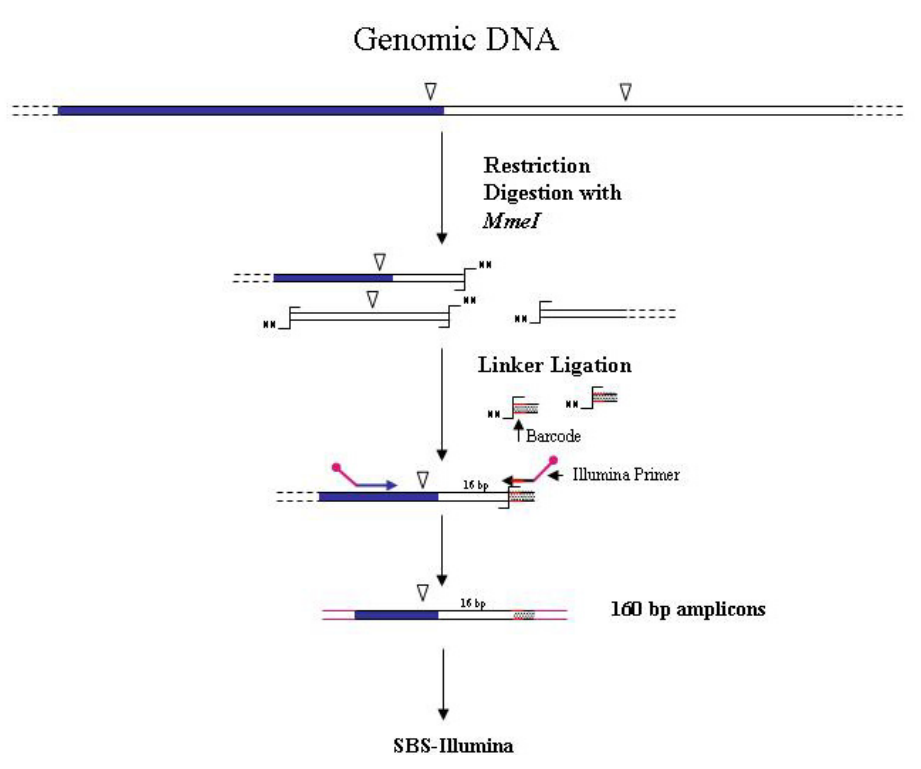
Figure 4. Main steps of MmeI -assisted cassette-PCR GW and SBS-Illumina association strategy. Blue and white bars correspond to known and unknown sequences, respectively. An open vertical arrow indicates the MmeI recognition site. The symbol indicates the MmeI digestion site. A black horizontal arrow indicates adapter specific primers; a blue arrow represents primers designed in the known region. Barcodes and Illumina sequencing traits of longer amplification primers are indicated in the